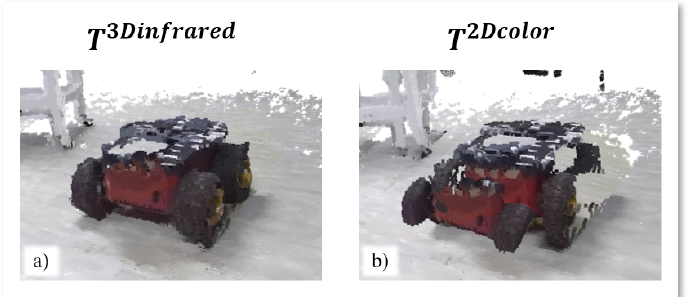
Figure 10. Visual representation of the ( a ) best ( T 3 Dinfrared ) and ( b ) worst ( T 2 Dcolor ) alignment of P infrared point clouds. he input point clouds are captured at the same timestamp from both the Azure Kinect